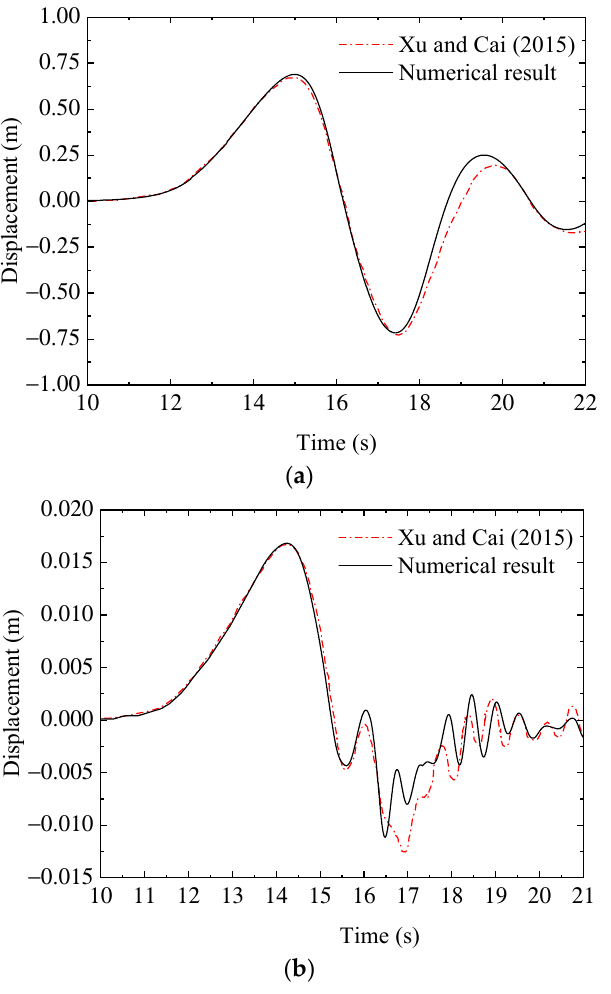
Figure 8. Comparison of the time histories of the displacement. ( a ) K43; ( b ) K1534. Figure 8. Comparisons of the vertical force between the numerical result of current study and the numerical result of Xu and Cai [36]. ( a ) K43; ( b ) K1534.